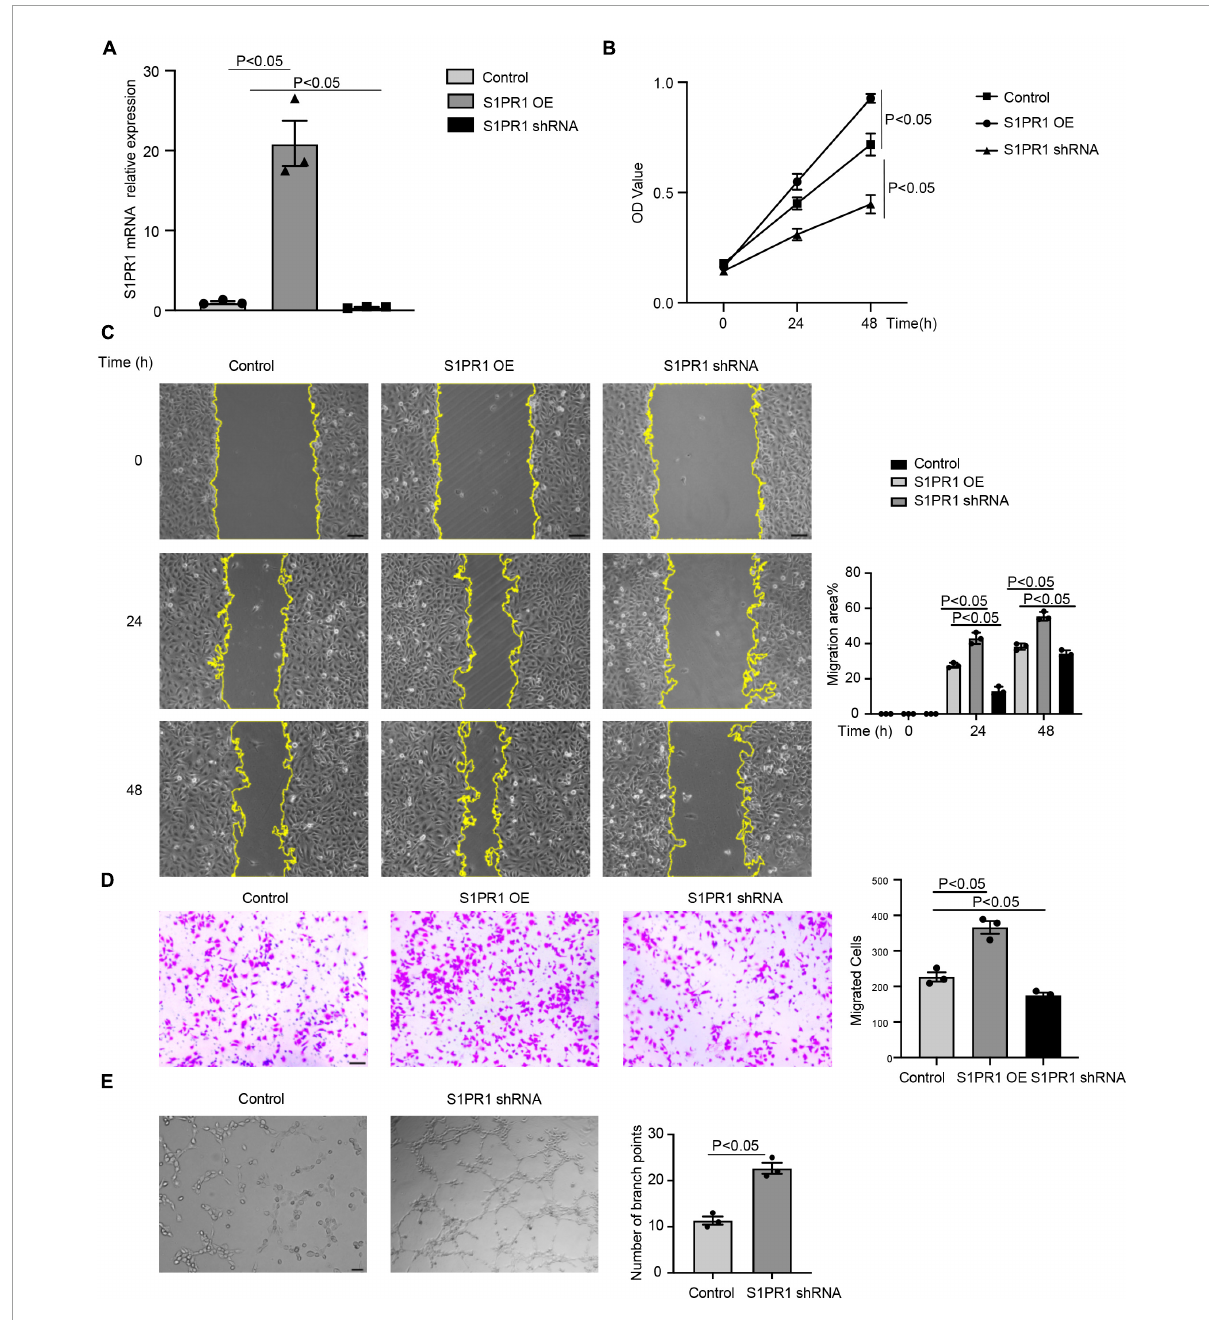
FIGURE4 S1pr1 regulates lymphatic endothelial cell migration, proliferation, and angiogenic activity. (A) RT-qPCR analysis of S1PR1 mRNA levels in LECs of the indicated group ( n = 3). (B) MTT assay showed the proliferation of cells of the indicated group ( n = 3). (C) Scratch wound healing assay showed the cell migration, with quantification of cell migration area (%) of the indicated group ( n = 3). (D) Boyden chamber assay showed the cell migration of cells of the indicated group, with quantification of migrated cells of the indicated group ( n = 3). (E) Tube formation assay showed S1PR1 shRNA promoted LEC tube formation, with quantification of the number of branch points ( n = 3). Control, scramble RNA lentivirus. OE, S1PR1-overexpressing lentivirus. shRNA, S1PR1 shRNA lentivirus. Data are mean ± S.E.M. Scale Bars: ( C–E) , 100 µ m.